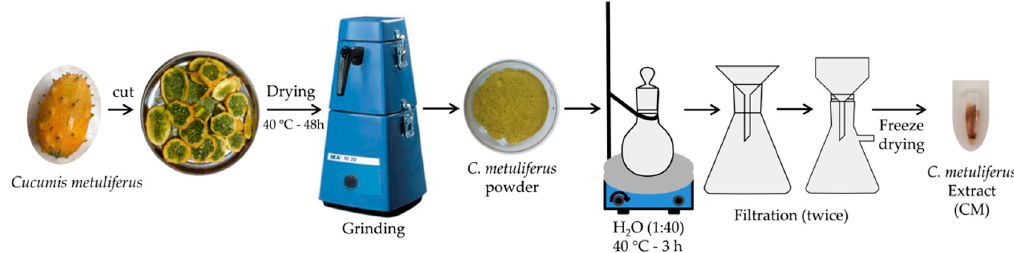
Figure 1. Schematic representation of antioxidants extraction procedure from Cucumis metuliferus fruit.